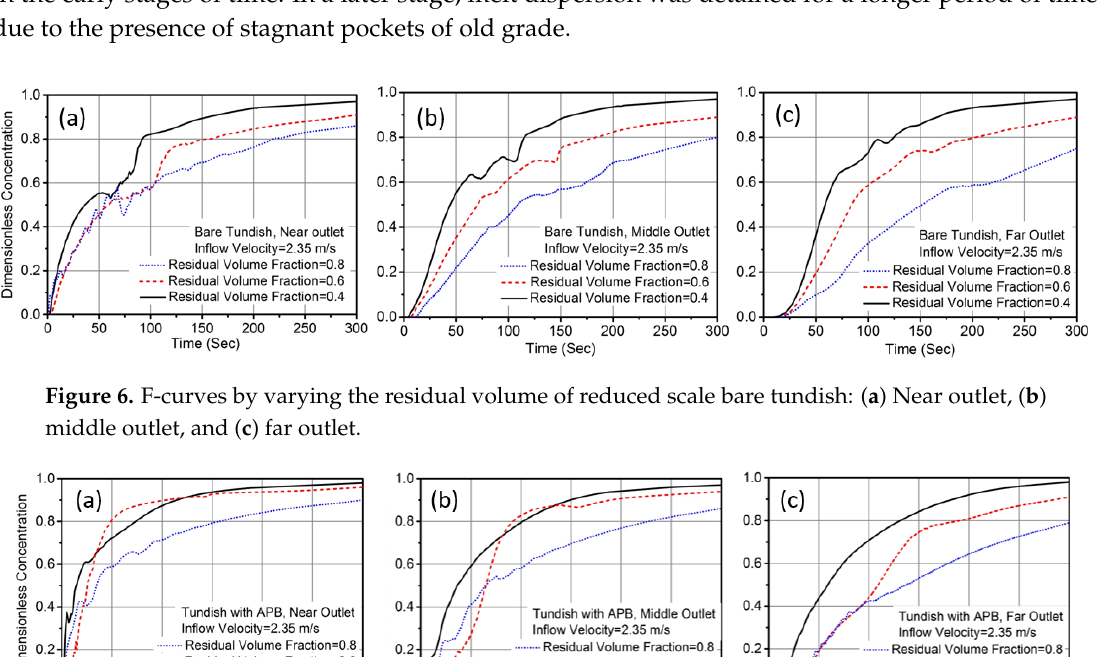
Figure 6. F-curves by varying the residual volume of reduced scale bare tundish: ( a ) Near outlet, ( b ) middle outlet, and ( c ) far outlet.